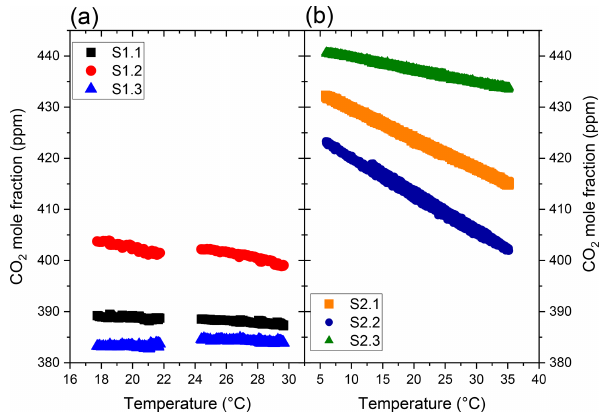
Figure 5. Linear relationships between reported {CO 2 } for S1.1 S1.1, S1.2 and S1.3 (a) at temperature values ranging from 17 to 30 ◦ C in the plastic chamber, and for S2.1, S2.2 and S2.3 at temper- ature values ranging from 5 to 35 ◦ C in the PIT chamber (b)